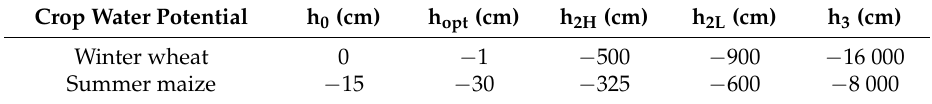
Table 2. Parameters of crop root water uptake in Hebei Low Plains in North China. Crop Water Potential Winter